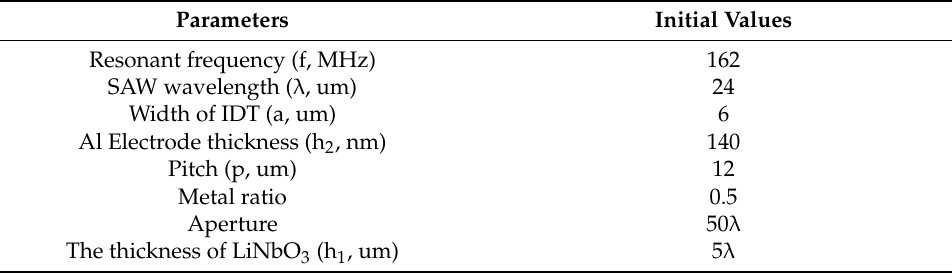
Table 1. The initial parameters of the SAW sensors with single electrode